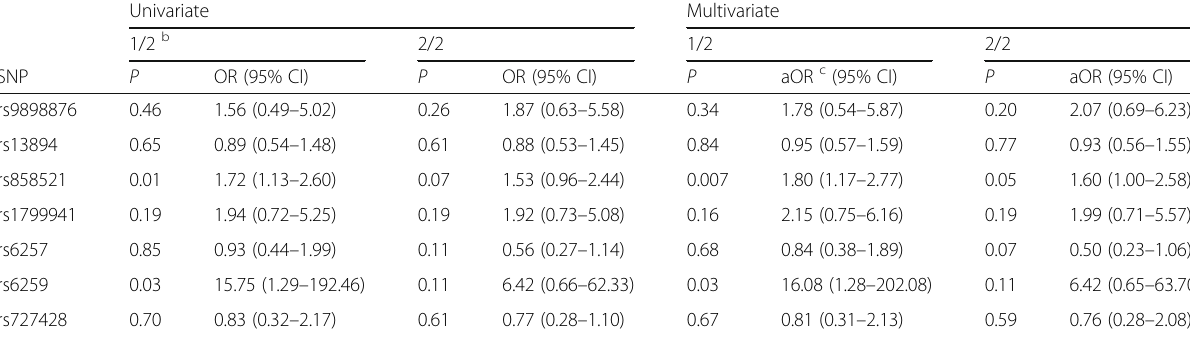
Table 4 Univariate and multivariate analysis of SHBG genotypes association with RPL a Univariate Multivariate